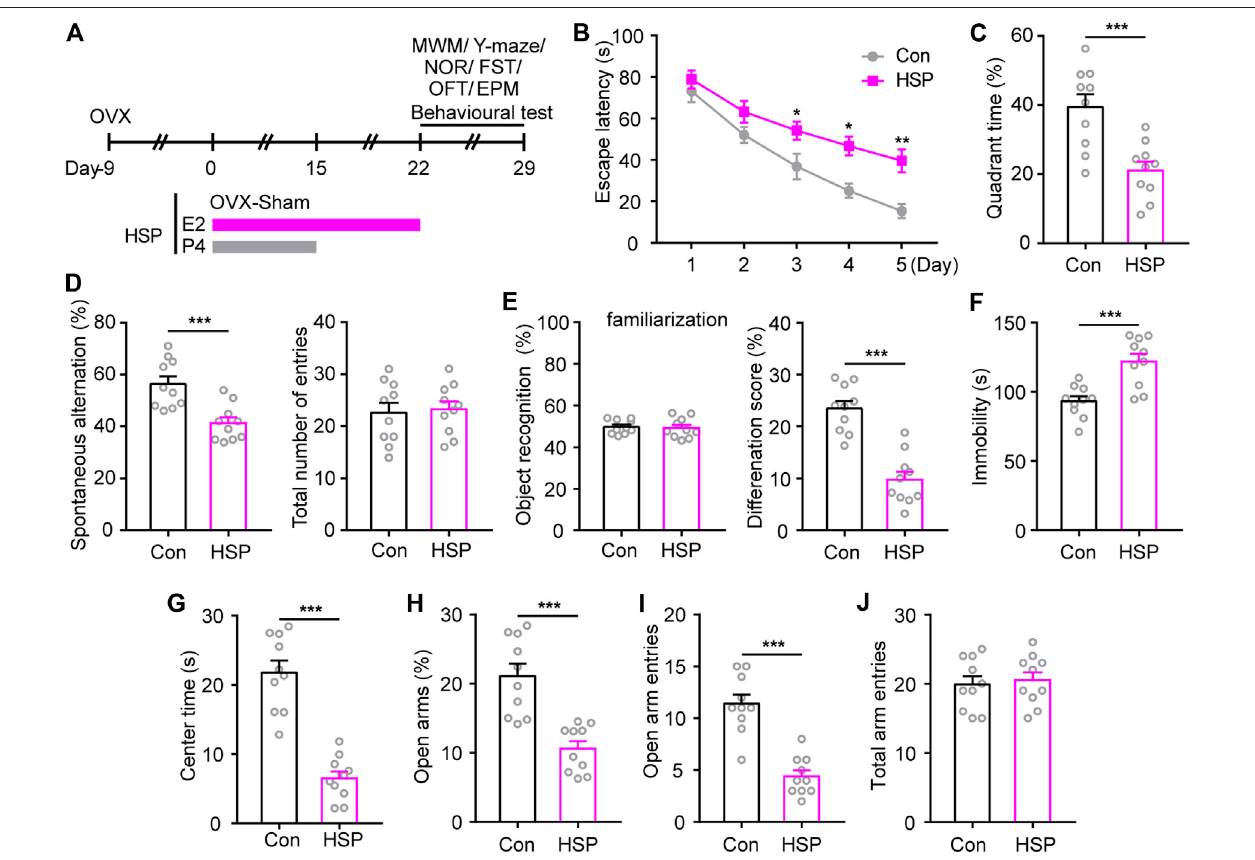
FIGURE 1 | Behavioral changes induced by HSP modeling. (A) Schematic timeline representation of HSP modeling and experimental design. (B) The latency to reachthehiddenplatformduringtheacquisitionphasefromtrainingdays1 – 5.Thelatencyduringthenavigationtrainingwasanalyzedusingtwo-wayrepeatedmeasures ANOVA:F(4,36) (cid:2) 35.86, p < 0.0001. (C) Thetimespentexploringthetargetquadrantofeachgrouponthe6thdayofprobetestswiththeremovedplatform.Student ’ s t -test:t (cid:2) 4.096, p (cid:2) 0.0007. (D) TheperformanceofspontaneousalterationsandtotalnumberofentriesintheY-mazetest.Student ’ s t -test:t (cid:2) 4.118, p (cid:2) 0.0006; Student ’ s t -test: t (cid:2) 0.2468, p (cid:2) 0.8079. (E) The preference for objects during familiarization and performance to distinguish familiar/novel objects in the NOR test. Student ’ s t -test: t (cid:2) 0.2549, p (cid:2) 0.8017; Student ’ s t -test: t (cid:2) 6.449, p < 0.0001. (F) Immobility time in FST. Student ’ s t -test: t (cid:2) 4.288, p (cid:2) 0.0004. (G) Time spent in the centralareaoftheopen- fi eldtest.Student ’ s t -test:t (cid:2) 7.649, p < 0.0001.Percentageoftimespentintheopenarm (H) ,entriesintoopenarms (I) ,andtotalarmentries (J) in the elevated plus maze (EPM) test. Student ’ s t -test: t (cid:2) 7.649, p < 0.0001; Student ’ s t -test: t (cid:2) 6.614, p < 0.0001; Student ’ s t -test: t (cid:2) 0.3619, p (cid:2) 0.7217. Data are presented as scatter points plus the mean ± SEM. n (cid:2) 10 for each group. * p < 0.05; ** p < 0.01; *** p < 0.001 compared with Con.